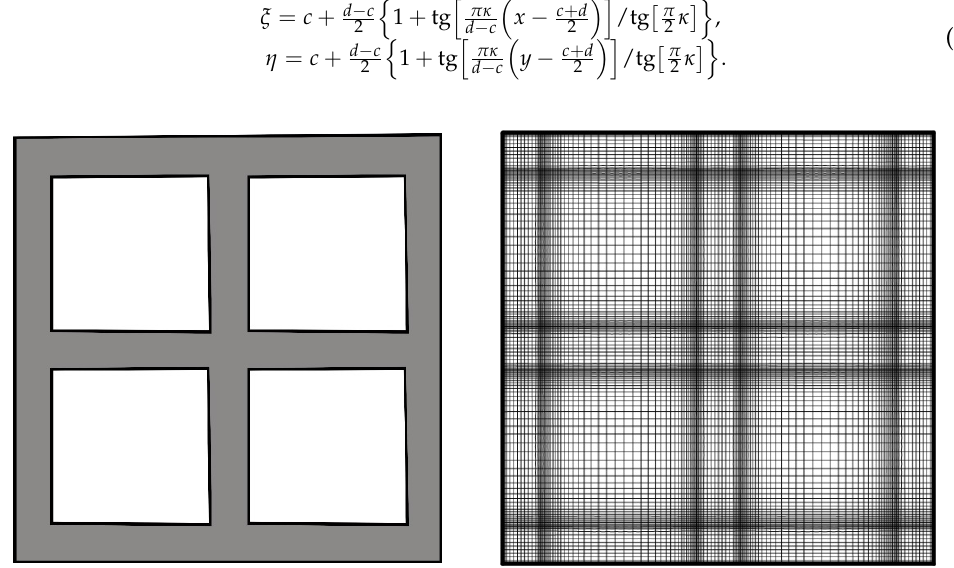
Figure 2. Computational domain and utilized mesh.